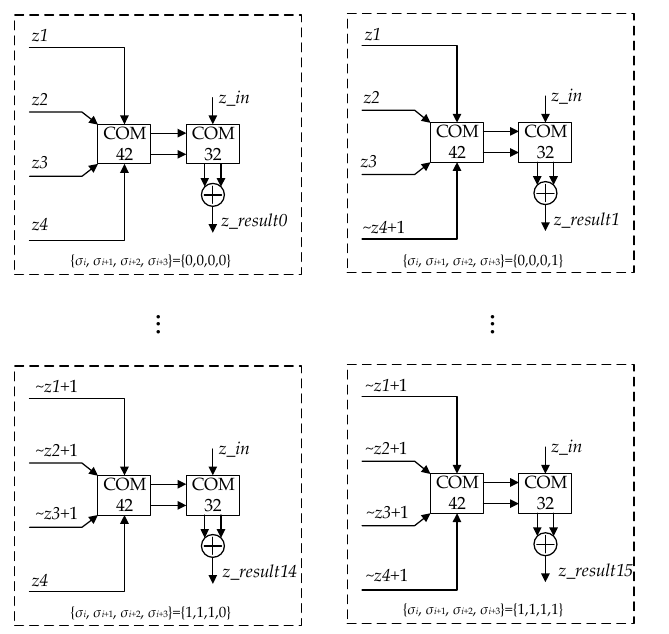
Figure 9. Architecture of module z_pre.